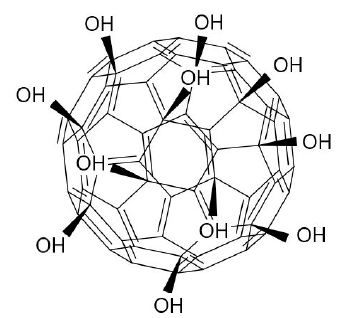
Figure 1. The structure of fullerenol C 60 (OH) x.